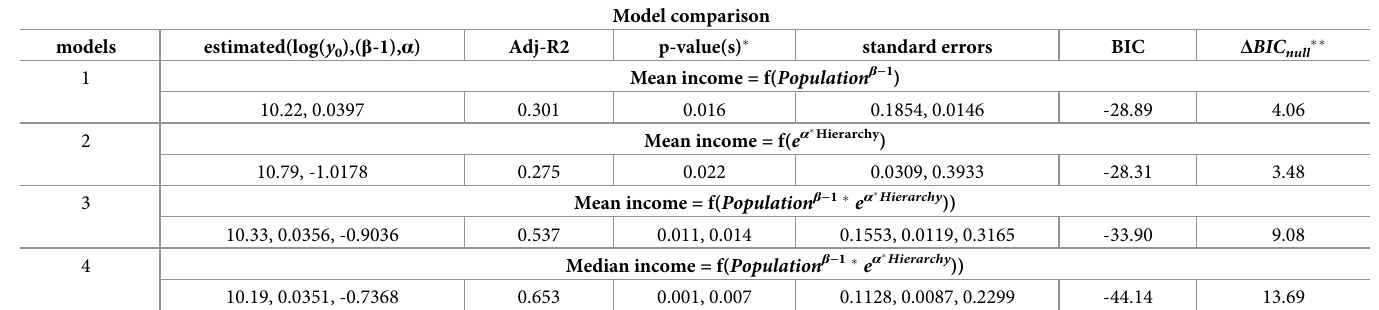
Table 2. Statistical analysis of different models using main explanatory variables.